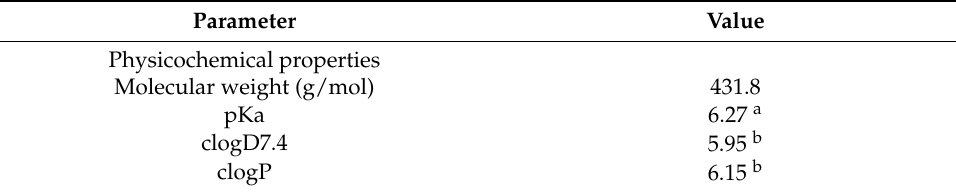
Table A2. Drug physicochemical properties.